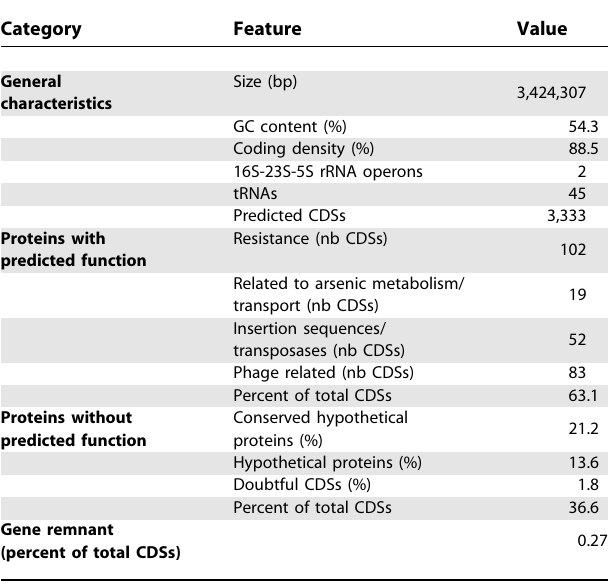
Table 1. General Features of the H. arsenicoxydans Genome